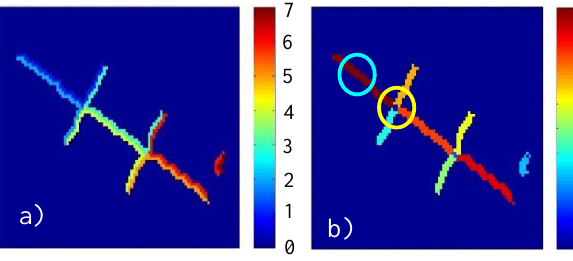
Figure 2. a) Detection of the inner planes boundaries; b) represent the plane numbers but in the (Figure 2b) the